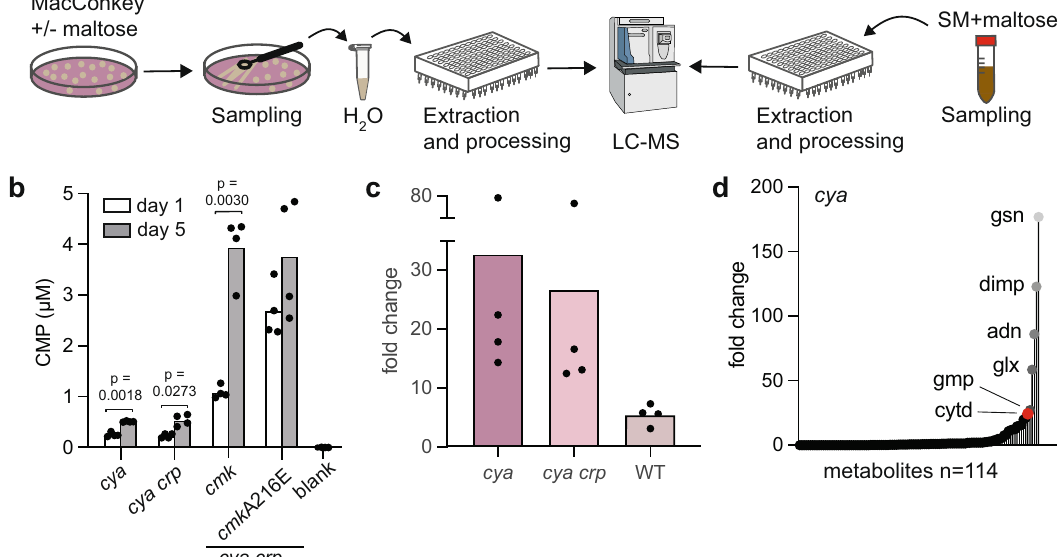
Fig. 2 Cytidine and CMP accumulate in ageing bacteria. a Schematic overview of biomass sampling from MacConkey agar plates or Simple MacConkey (SM) liquid cultures for metabolomics with liquid chromatography-mass spectrometry (LC-MS). b Absolute cytidine monophosphate (CMP) levels from sampling day one (white) and fi ve (grey). Signi fi cance was based on two-sided paired t-tests between the groups indicated, and designated as signi fi cant if p < 0.05. Data represent four replicates. c Fold change of absolute cytidine levels in cya, cya crp, and WT (differentiated by color) for days one to six. Data represent four replicates. d Distribution of fold changes of all metabolites detected by LC-MS from day one to six for cya . The metabolites with the highest fold change are highlighted. From light to darker grey: gsn: guanosine, dimp: deoxyinosine monophosphate, adn: adenosine, glx: glyoxylate, gmp: guanosine monophosphate, cytd: cytidine (red). Data represents the average of four replicates. Source data are provided as Supplementary Data